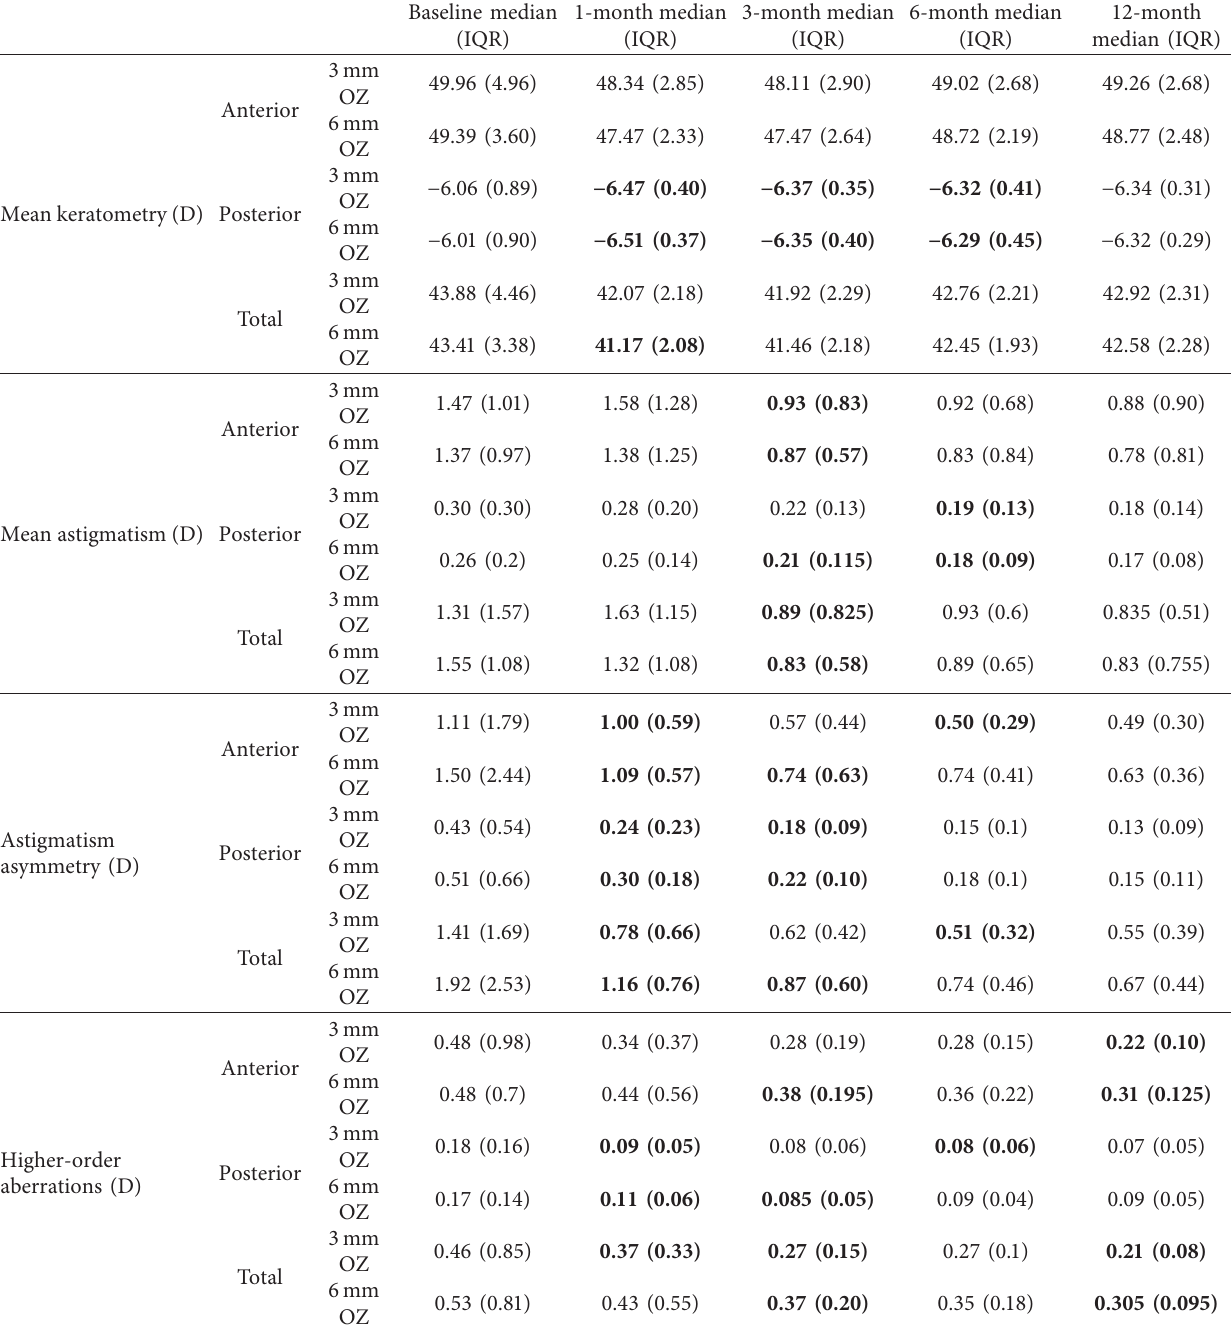
Table 2: The dynamics of changes in mean keratometry, astigmatism magnitude, astigmatism asymmetry, and higher-order aberration power between the follow-up time points in the different corneal optical zones after Descemet membrane endothelial